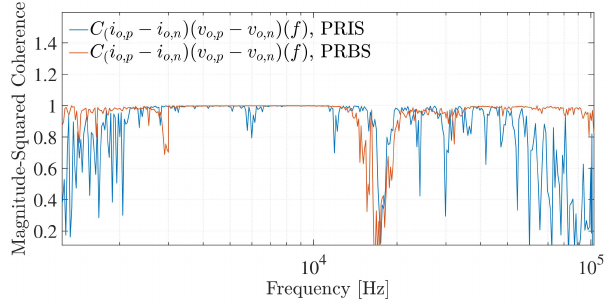
( f ) , using PRIS and o , p ( t ) − i o , n ( t )) , ( v o , p ( t ) − v o , n ( t ))